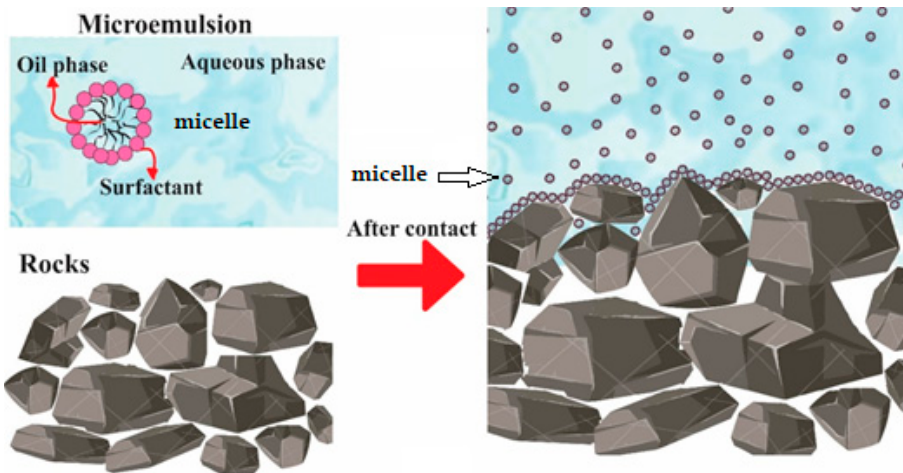
Figure 8. Scheme of microemulsion adsorption on a rock